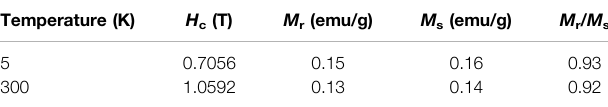
TABLE 3 | Parameters of the ferromagnetic part of the magnetization hysteresis loops recorded at 5 and 300 K for the as-prepared BiFeO 3 . H c is the coercive fi eld; M r is the remanent magnetization; M s is the saturation magnetization. Temperature (K)